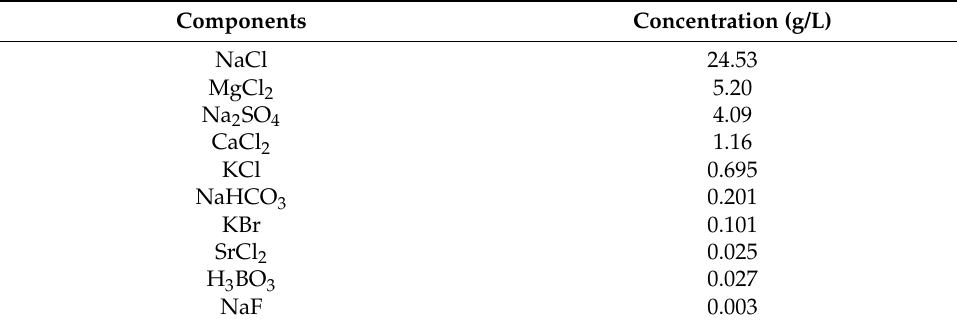
Table 2. The chemical compositions of